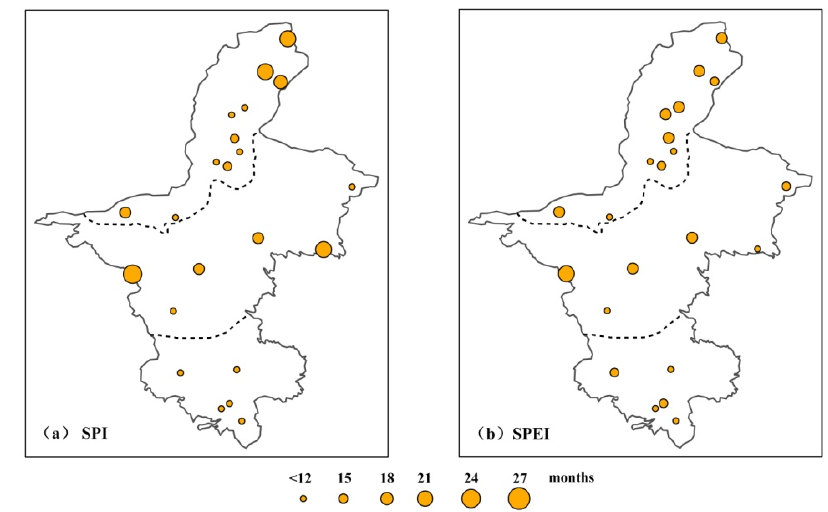
Figure 6. Maximum durations of drought events identified from monthly SPI/SPEI values at the 3-month time scale for 22 stations during the years 1972–2011 in Ningxia. ( a ) SPI, ( b )